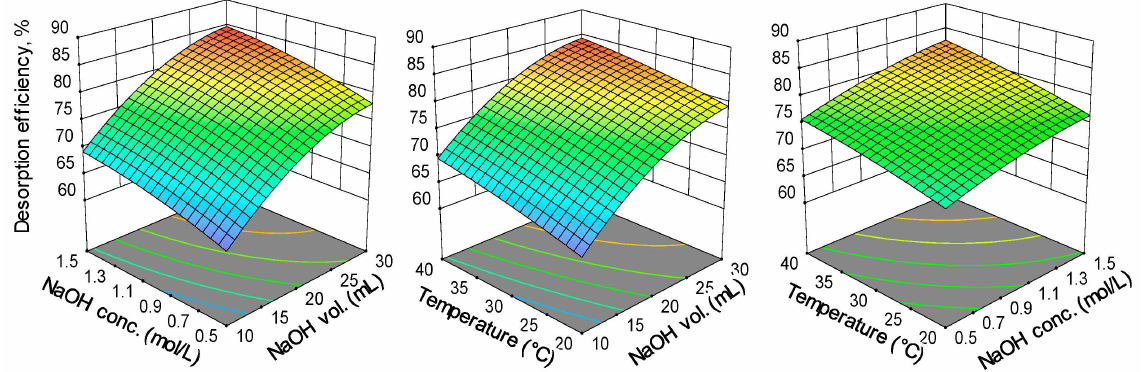
Figure 2. 3D response surface plots of Box–Behnken Design.